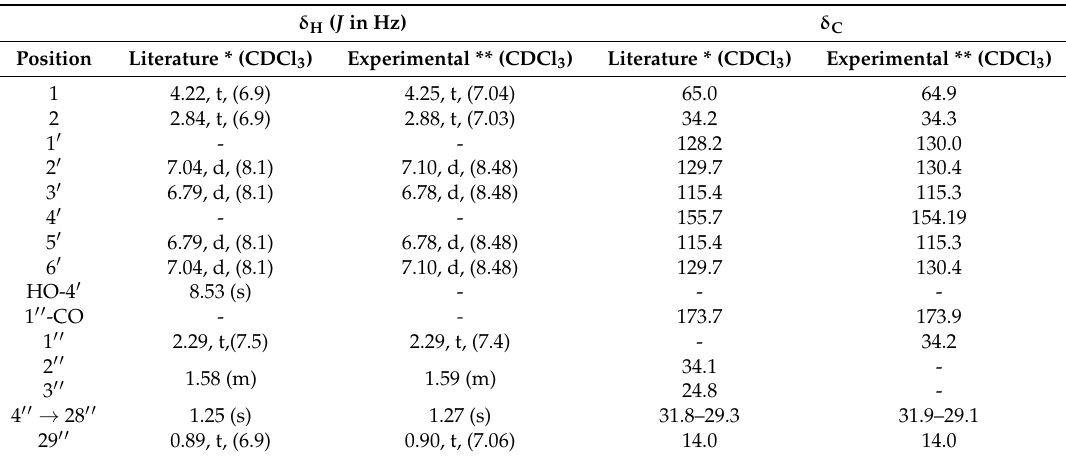
Table 1. 1 H-NMR and 13 C-NMR data for basalethanoïd B ( 1 ) [8]. δ H ( J in Hz) δ